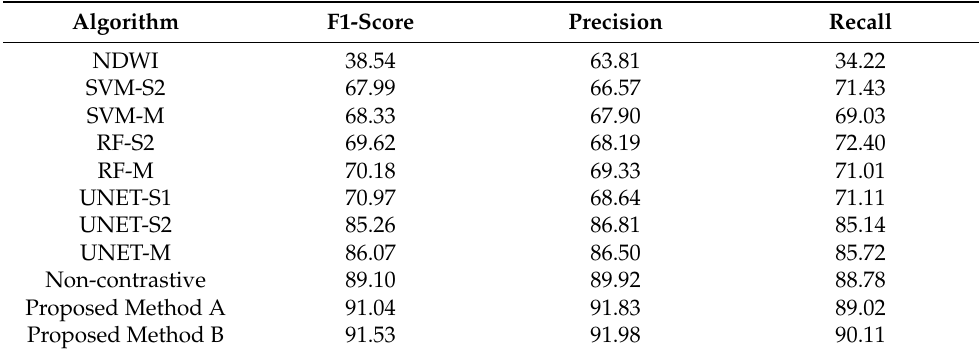
Table 4. Comparison between the proposed method and baseline methods segmentation performance on the testing